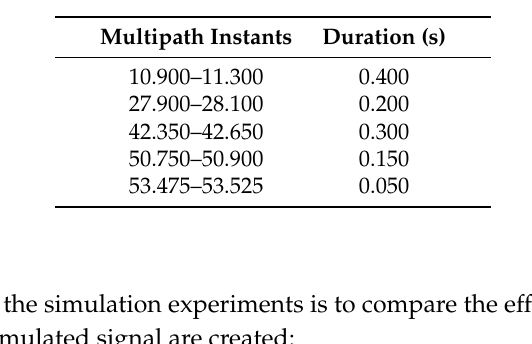
Table 1. Time windows when MP is